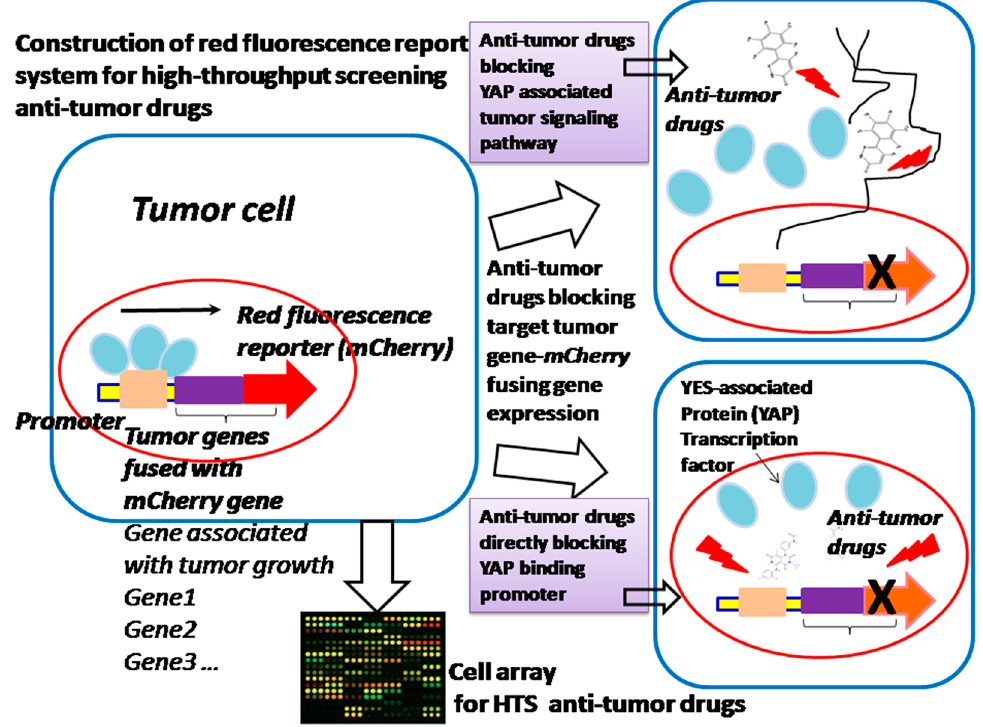
Figure 4. Construction of HTS platform (cell array) for HTS anti-tumor drugs. Anti-tumor drugs block YES-associated protein (YAP) transcription of tumor genes, which can be applied for drug HTS.